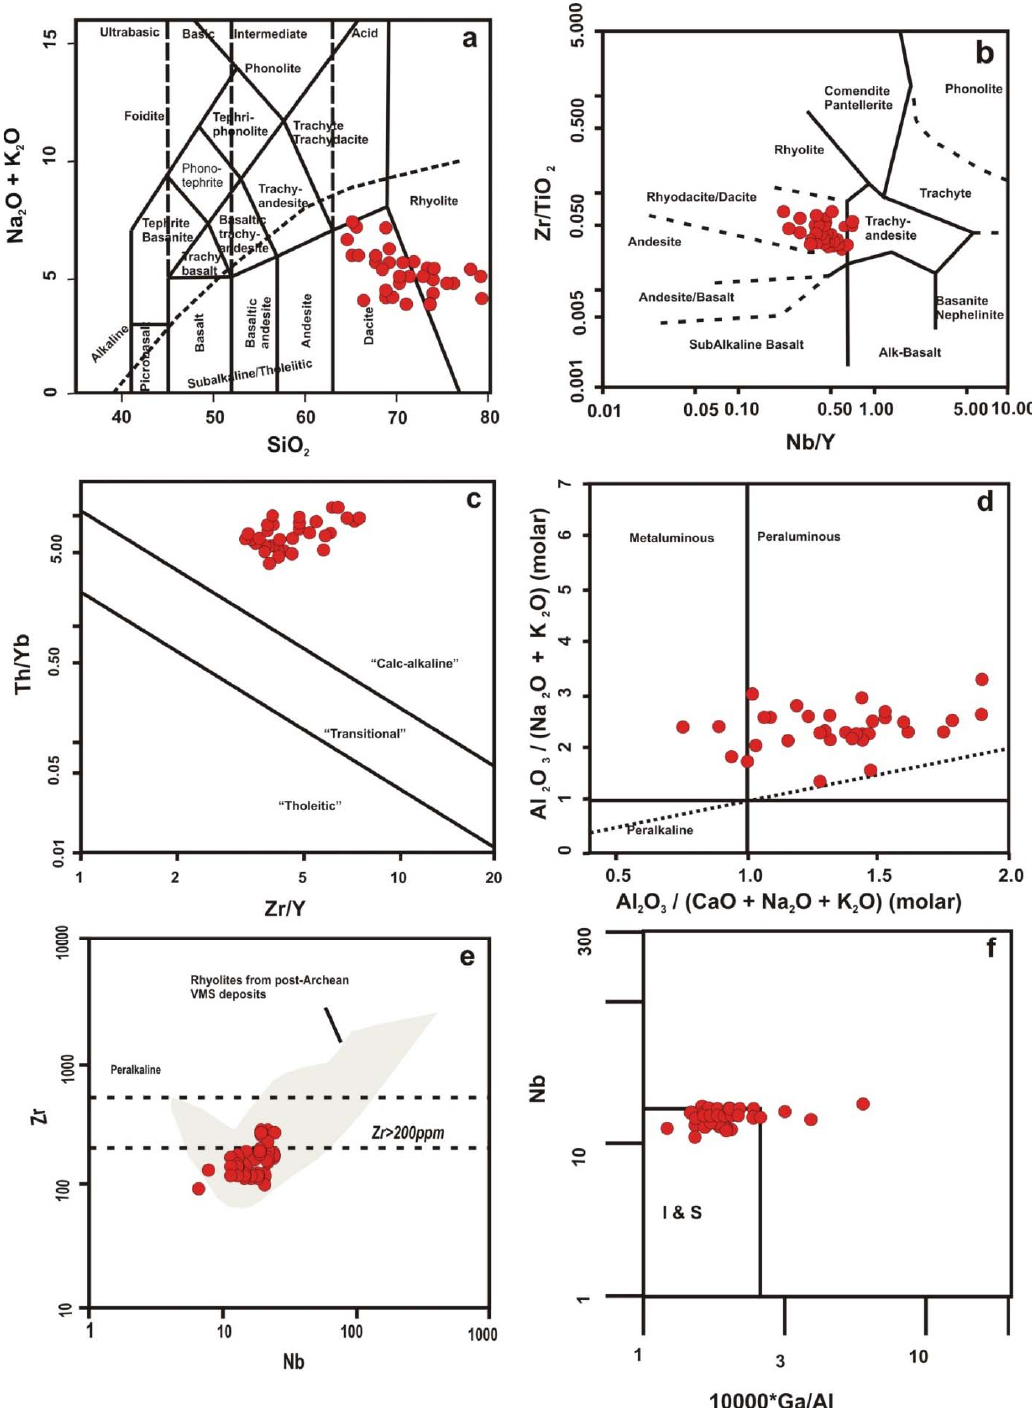
Figure 9. Felsic volcanic rocks from Mundiyawas-Khera copper deposit plotted against the dis- crimination diagram: ( a ) Total Alkali vs. Silica (TAS) plot after [56] show within rhyolite and dacite field; ( b ) Zr/TiO 2 discrimination diagram of [57] plot well within the rhyo-dacite/dacite field; ( c ) Th/YbvsZr/Y plot after [58] show calc-alkaline affinity; ( d ) Al 2 O 3 /(Na 2 O + K 2 O) (molar) vs. Al 2 O 3 /(CaO + Na 2 O + K 2 O) (molar) plot shows a meta-aluminous to peraluminous character [59]; ( e ) Zr vs. Nb diagram showing similarities with rhyolites from post-Archean VMS deposits. The Zr- Nb diagram illustrates the HFSE variations in rhyolitic rocks associated with VMS environments [60]; ( f ) Nb vs. Ga/Al, all sample plots in the I & S-type except a few falling in A-type granite field [61]. (Data source: Table